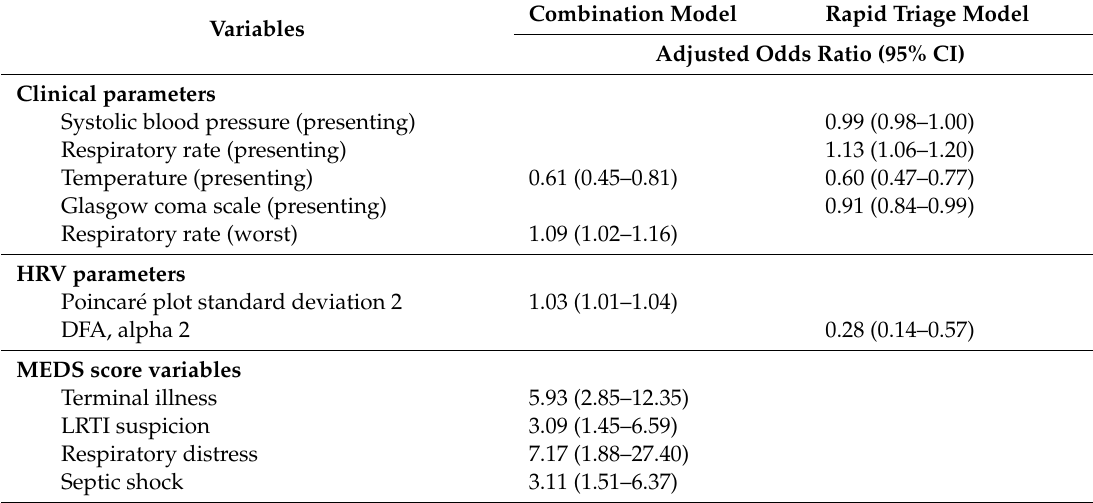
Table 3. Multivariable logistic regression models for prediction of 30-day IHM. The combination model utilizes information made available over the entire course of a patient’s emergency department